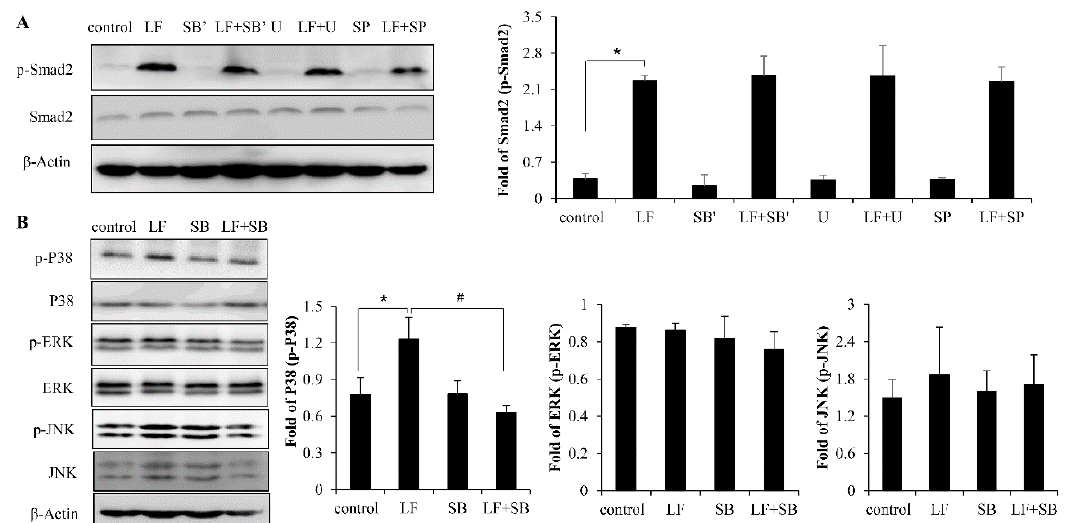
Figure 6. The crosstalk effect between LF-induced activation of TGF-β canonical and noncanonical signaling. ( A ) Pre-treating cells with inhibitors cannot attenuate LF (100 μg/mL)-induced Smad2 activation in MSCs. ( B ) After pretreating cells with SB, LF (100μg/mL)-induced phosphorylation P38, ERK1/2, and JNK activation were detected. Values are mean ± SDs, n = 3. (* p < 0.05 versus control group; # p < 0.05 versus LF+SB treated group).